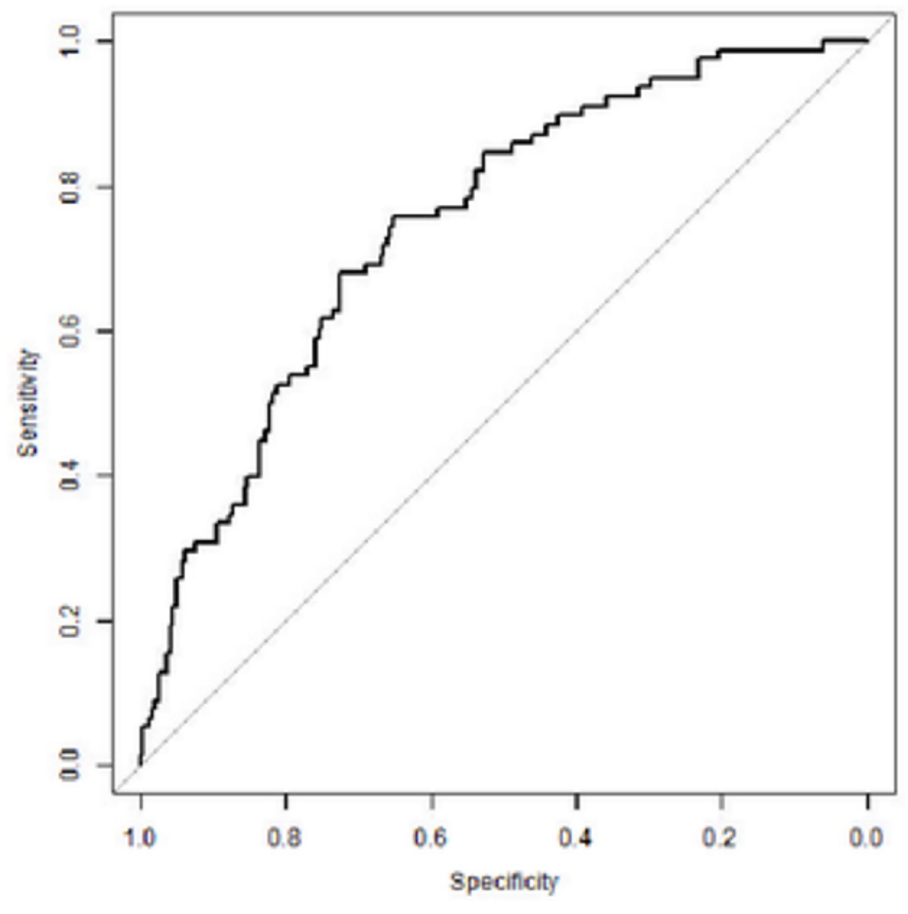
Fig 1. Receiver operating characteristic curve of V E /VCO 2 slope and post-operative cardiovascular complications. Multivariate logistic regression model [AUC = 0.747 (0.687; 0.807)].